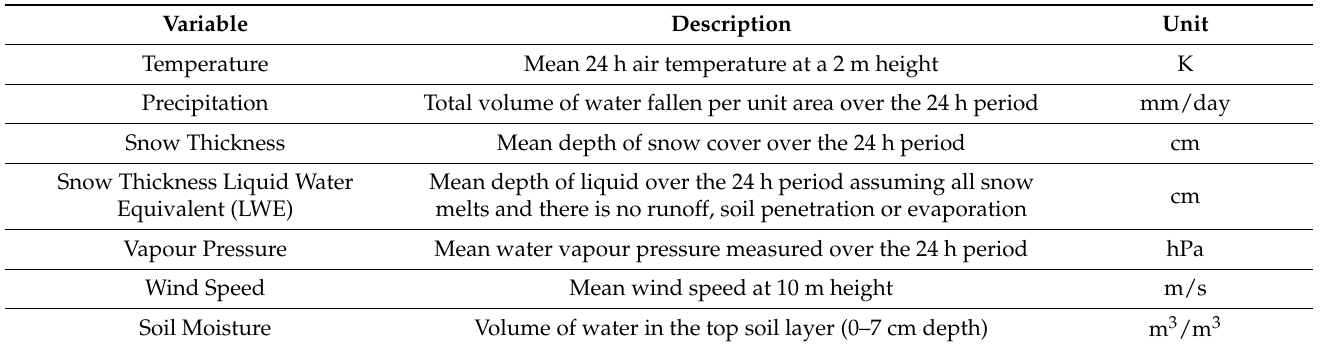
Table 2. List of climate variables that were taken into consideration in the scope of this